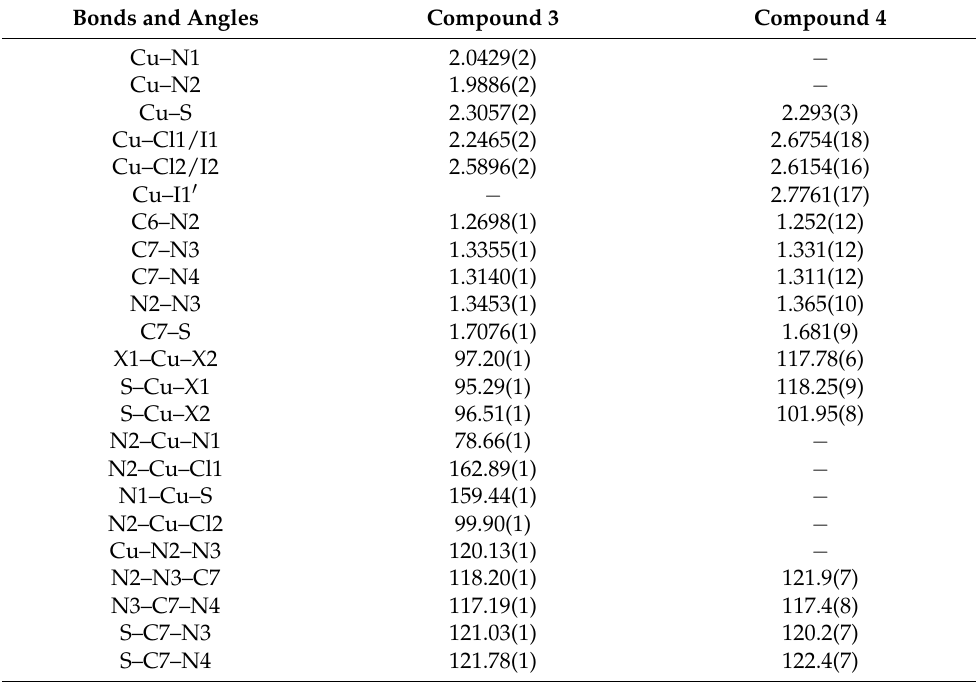
Figure 1. Crystal structure of the [Cu(HL)Cl 2 ] unit in 3 . Thermal ellipsoids are drawn at 30% probability level. Table 2. Selected bond distances (Å) and angles ( ◦ ) for compounds 3 and 4 .